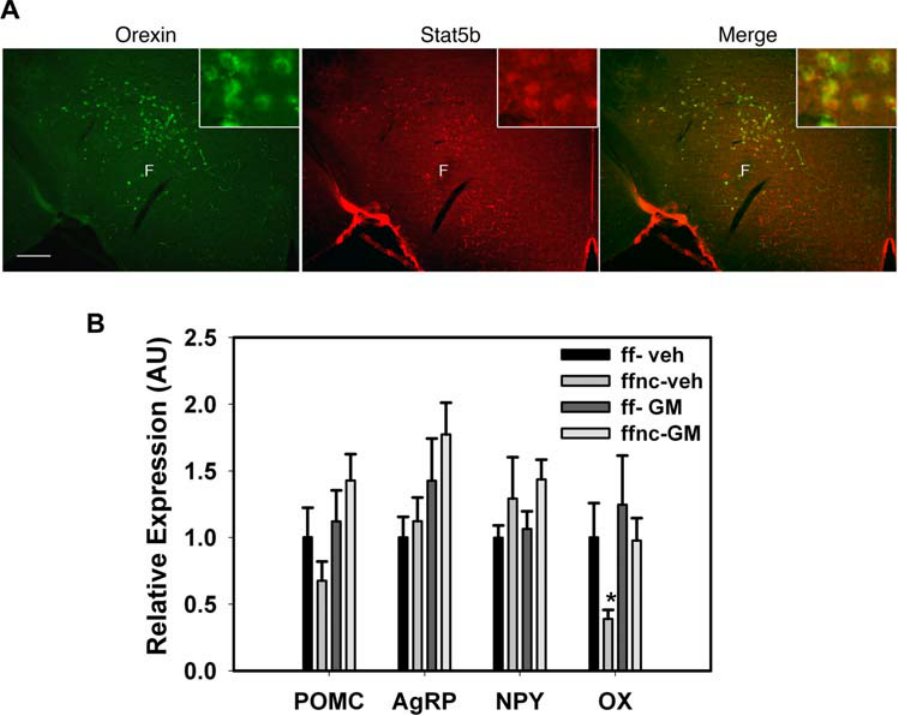
Figure 10. Potential role for Stat5 in OX-expressing LHA neurons in mice. (A) Histochemical sections from perfused wild-type male mice were subjected to immunostaining for OX (green, left) and STAT5B (red, middle). Right panel shows merged images demonstrating co-localization of prominent STAT5B expression with OX-expression in the LHA. Insets: magnified view of co-labeled neurons. F=fornix. (B) Total RNA prepared from whole hypothalamus tissue from and Stat5 fl/f (ff) and Stat5 fl/fl; Nestin-Cre (ffnc) mice treated with vehicle (veh) or GM-CSF (GM) was subjected to semi- quantitative real-time PCR for POMC, AgRP, NPY and OX mRNA expression. n . 5; *p=0.01 versus Wt Veh, S5, Veh by ANOVA F(3, 55)=4.383 with Fisher’s LSD test.